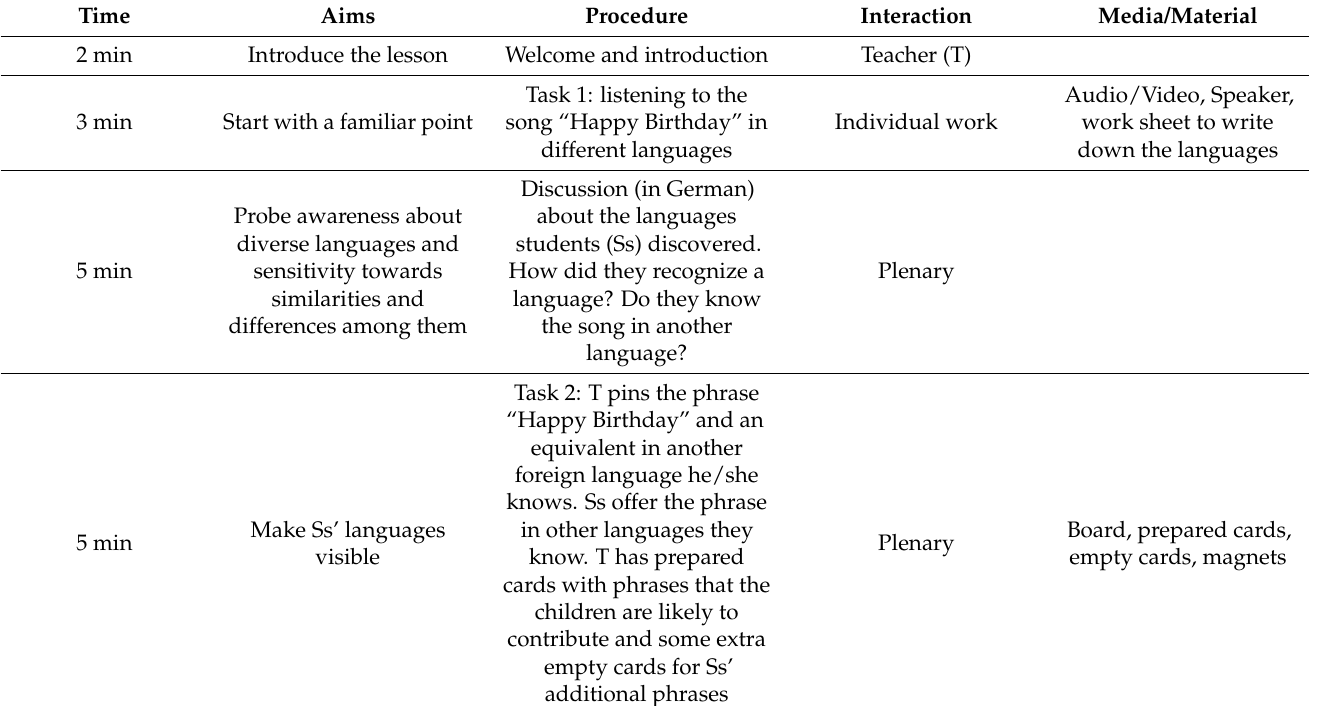
Table 1. Lesson plan for multilingual birthday